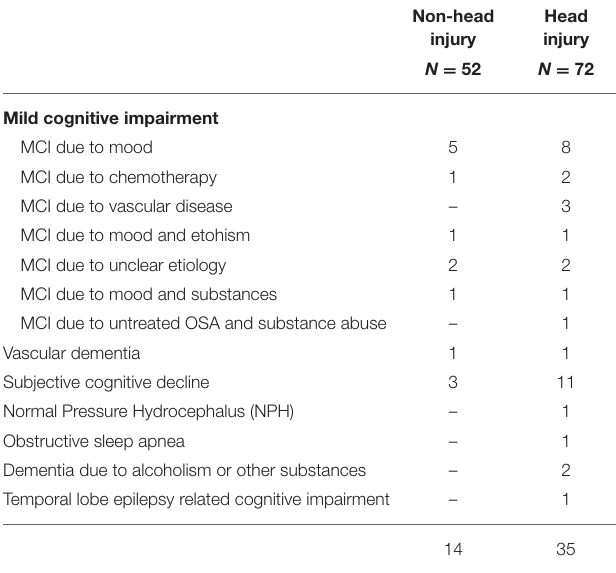
TABLE 5 | Non-neurodegenerative clinical